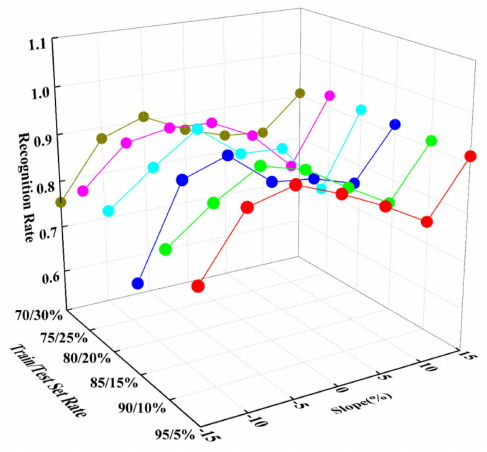
Figure 8. The recognition rate of lower-limb EMG signal according to the slope.